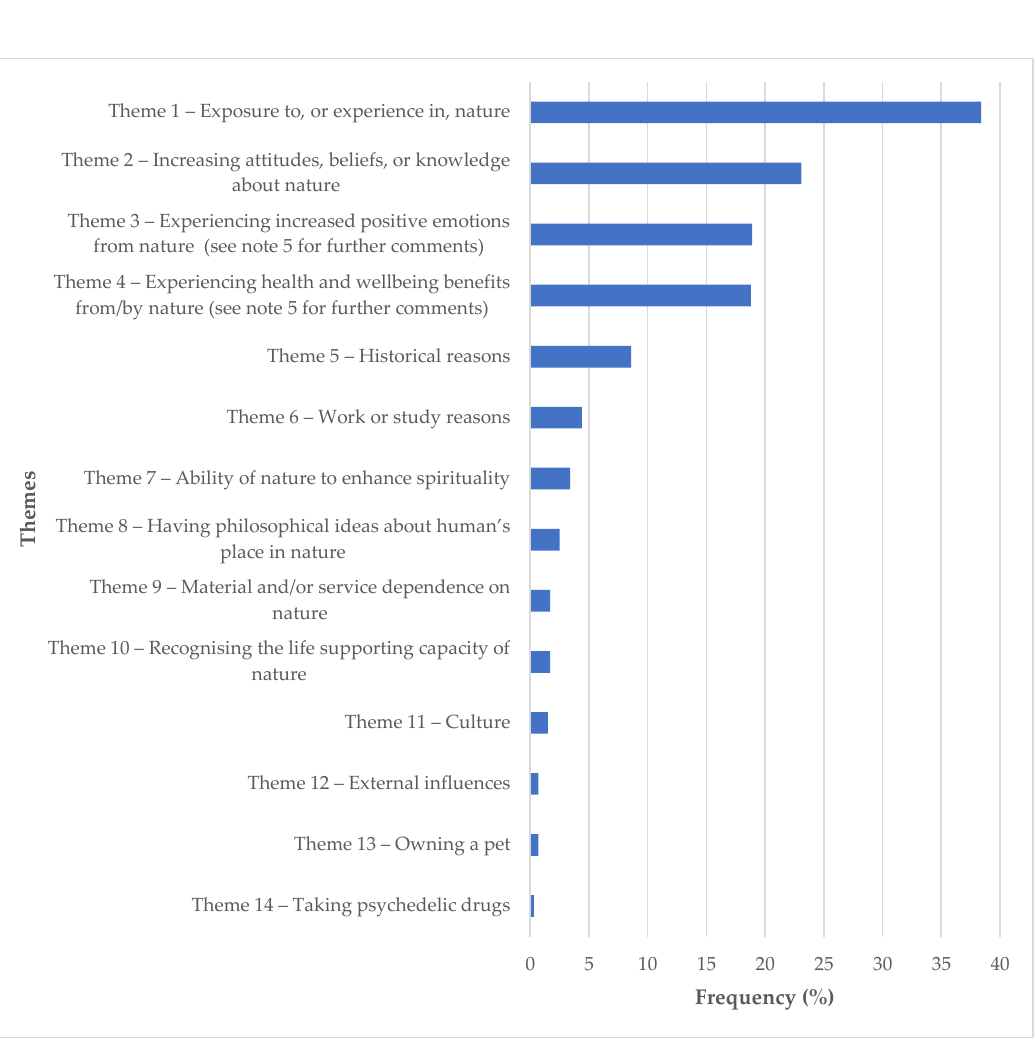
Figure 1. Perceived pathways to the connections to nature.